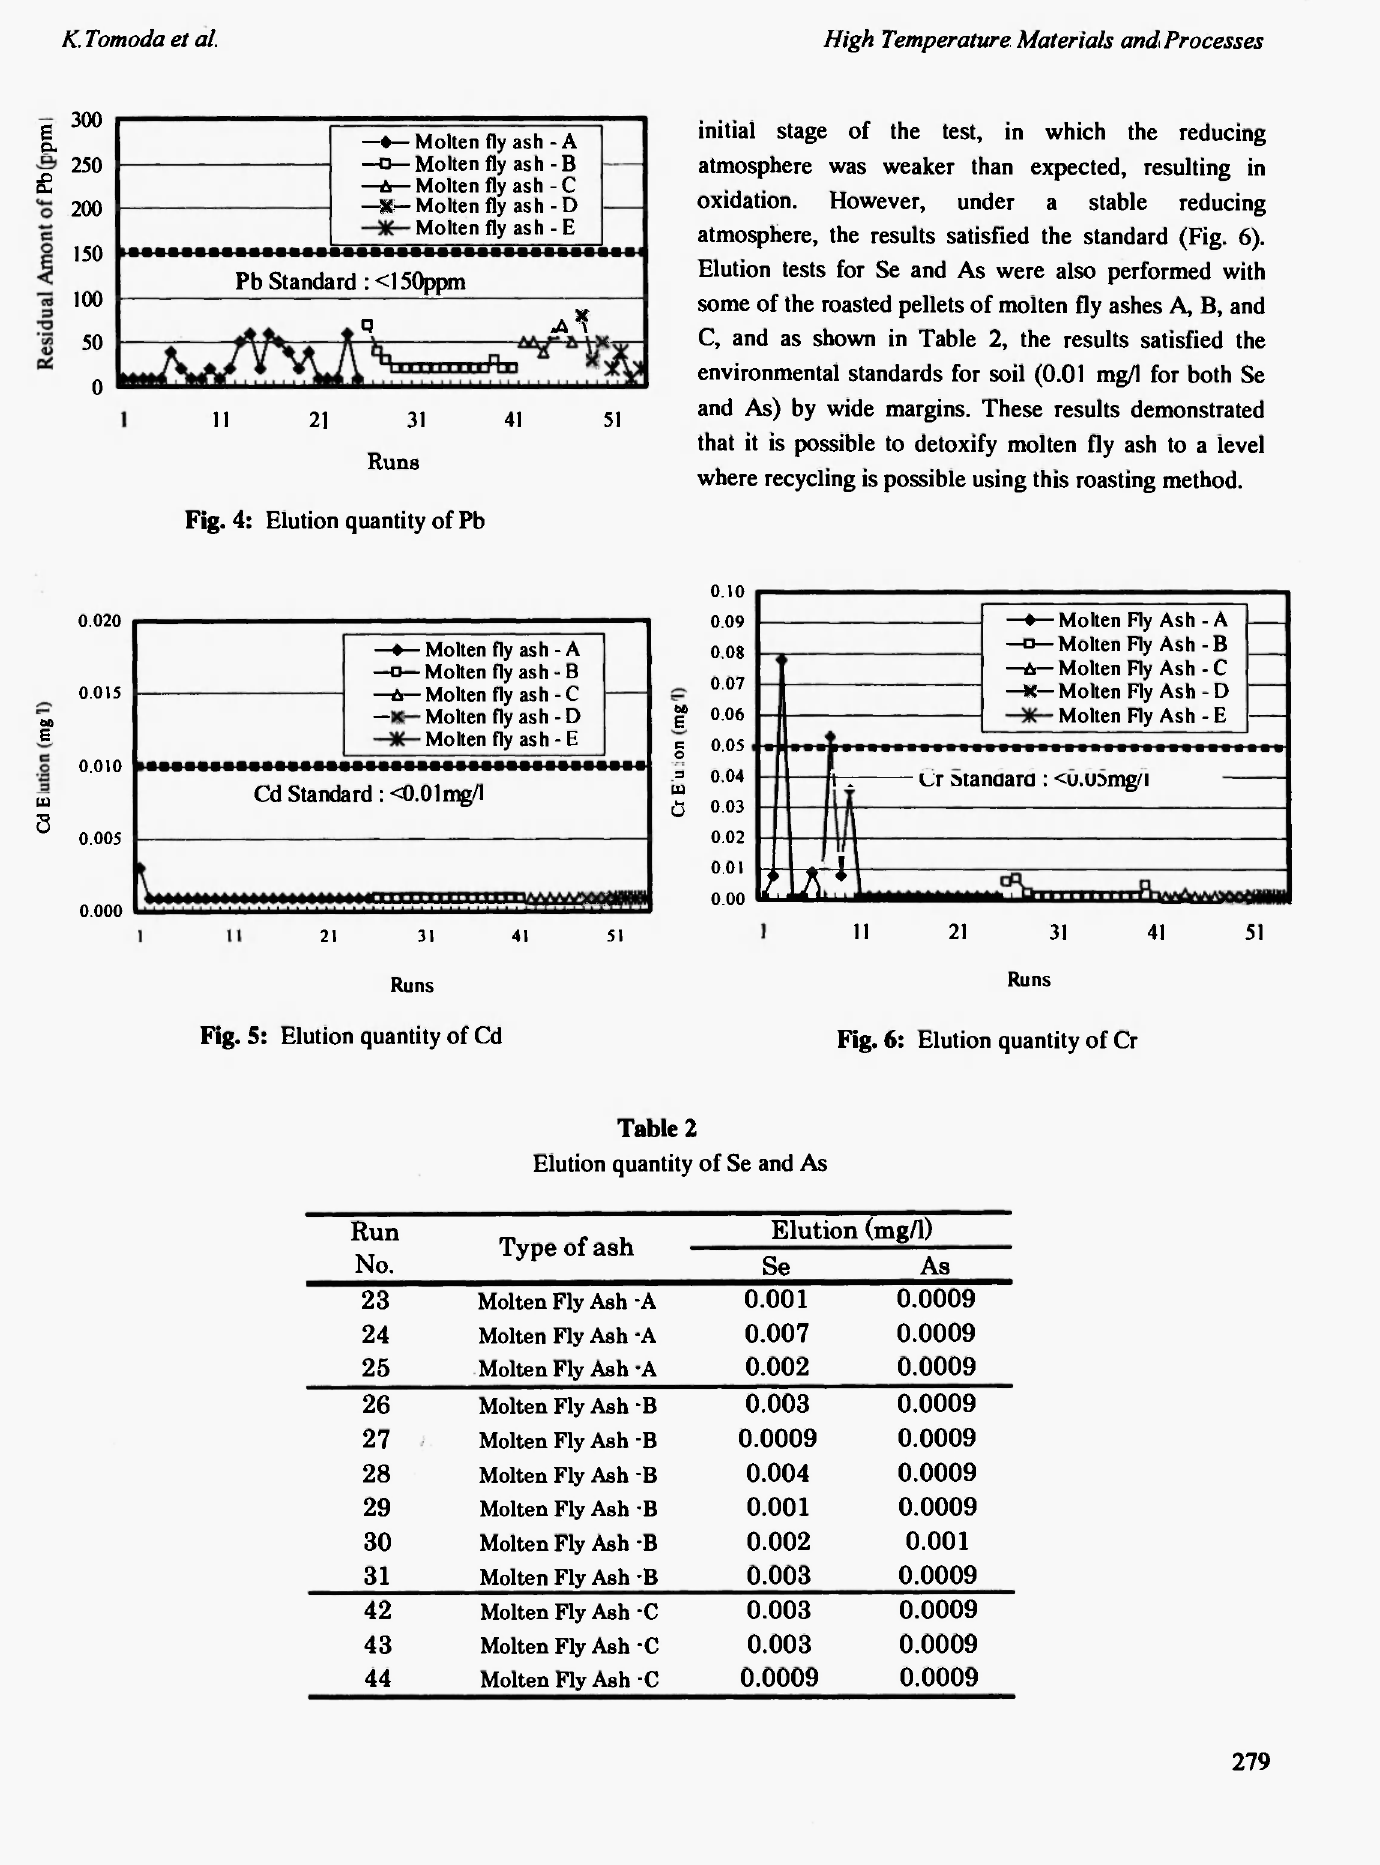
Fig. 4: Elution quantity of Pb